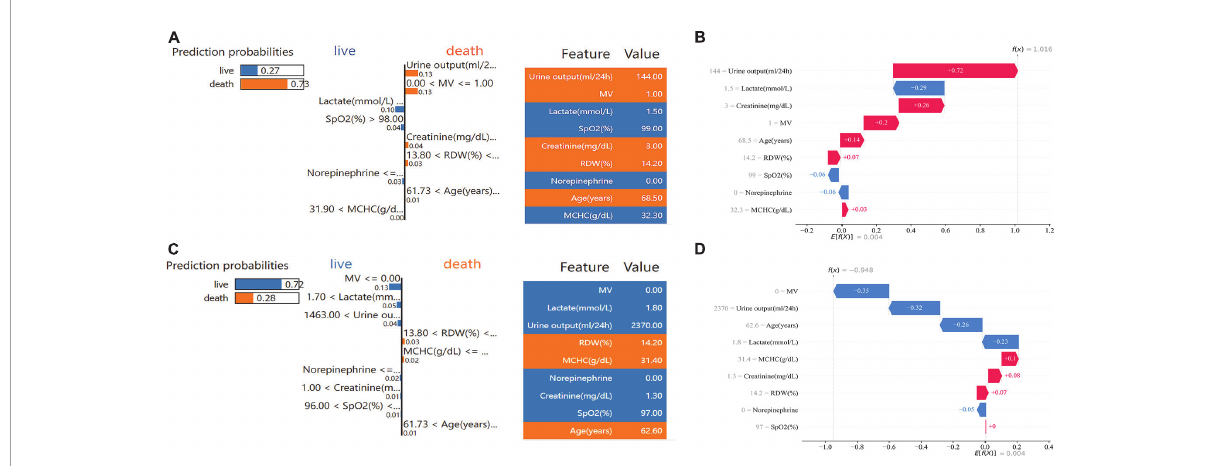
FIGURE7 Specific prediction and interpretation of the S-CatBoost model for two patients. (A,C) Individual prediction interpretation based on SHAP; (B,D) individual prediction interpretation based on the LIME method. S-Catboost: simplified Catboost model. SHAP, Shapley Additive Explanations; LIME, Local Interpretable Model-agnostic Explanations; MV, mechanical ventilation; SPO2, saturation of pulse oxygen; MCHC, mean corpuscular hemoglobin concentration; RDW, red blood cell distribution